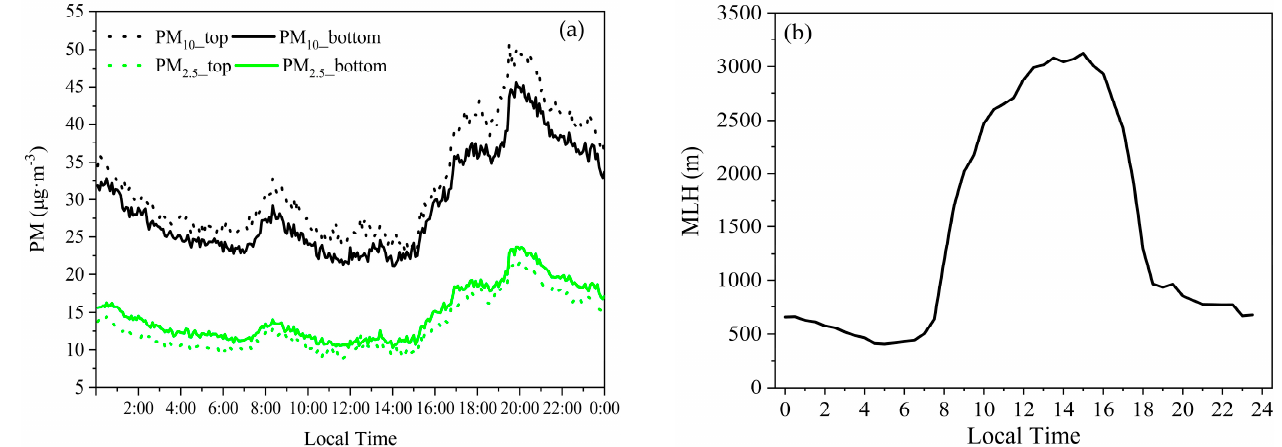
Figure 4. Mean diurnal variations in dust concentrations ( a ) and MLH ( b ) during observation in the TD.